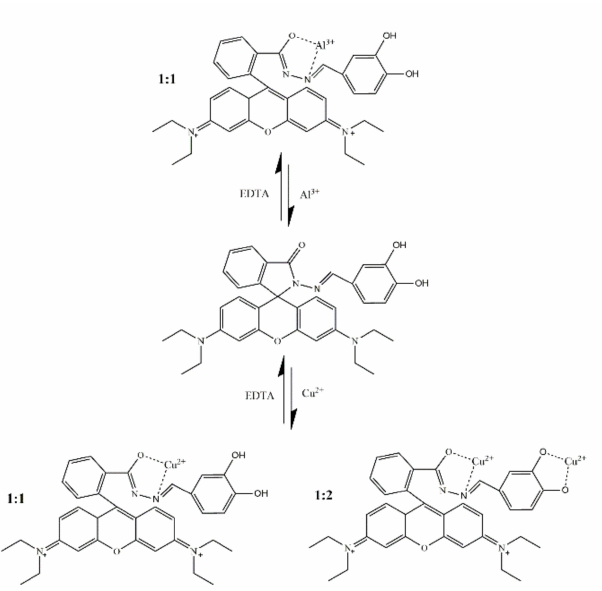
Figure 56. The proposed mechanism for interaction between R34 (Table 4, No. 7) and Al 3+ /Cu 2+ [112]. Zhang Z., et al. reported a rhodamine-based sensor with solvent-dependent binding properties for differential detection of Cr 3+ and Cu 2+ (Table 4, No. 8) [113]. The sensor depicted a turn-on fluorescence response with high selectivity and sensitivity to Cr 3+ and Cu 2+ in acetonitrile and ethanol solution, respectively (Figure 57). In acetonitrile medium, the acquired sensor showed different colorimetric, providing easy and differential analysis of Cr 3+ and Cu 2+ through naked eyes.